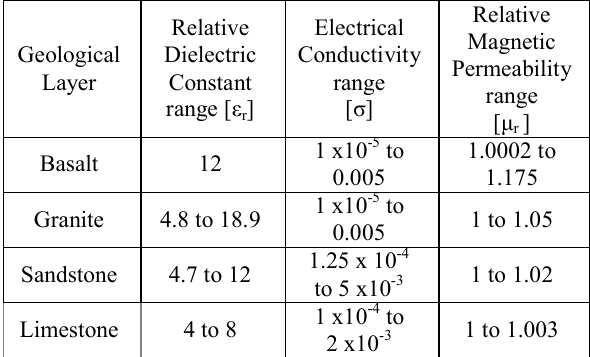
Table 1: Physical Properties of the four geological layers used in paper.